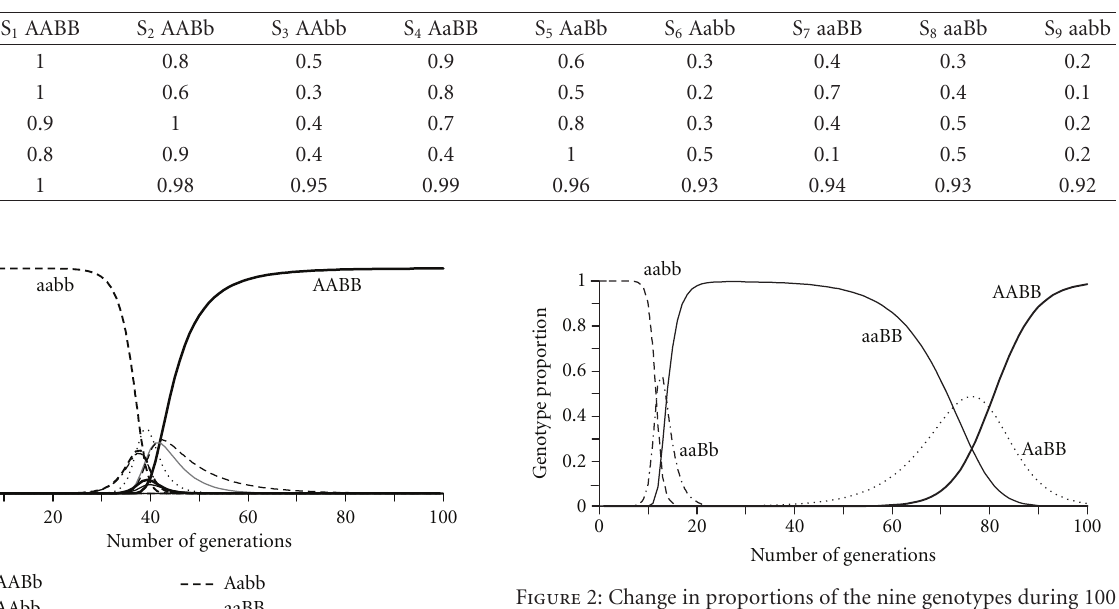
Table 2: Survival factors (S 1 to S 9 ) of the nine genotypes used in the five example models.